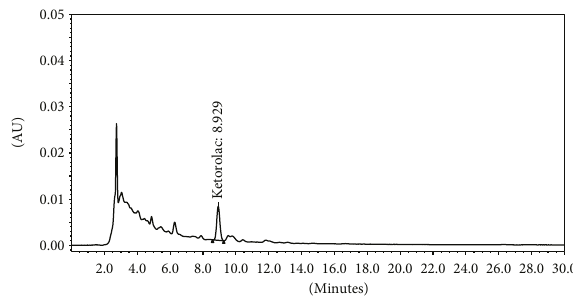
Figure 6: Chromatogram for the sample wastewater hospital treatment plant.